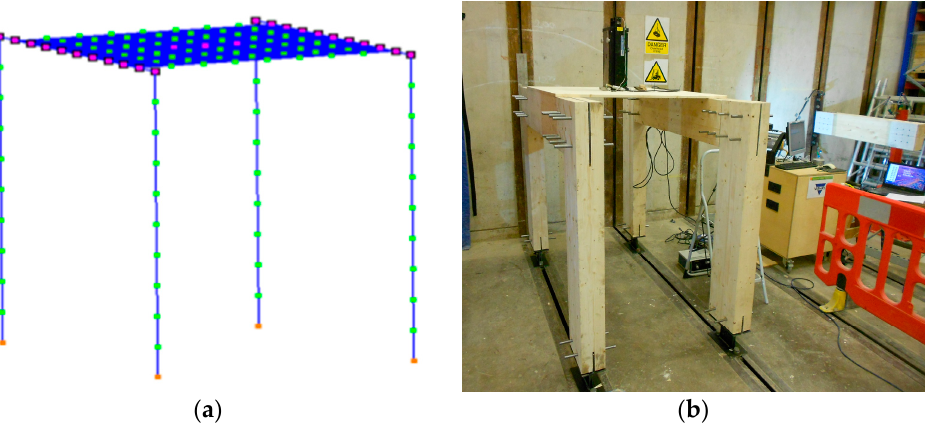
Figure 14. ( a ) OpenSees numerical model; ( b ) portal frame under vertical vibration. Table 3. Properties of GL 24h according to EN 14080:2013 [28] assumed in the numerical simulation. E 0 , g , mean